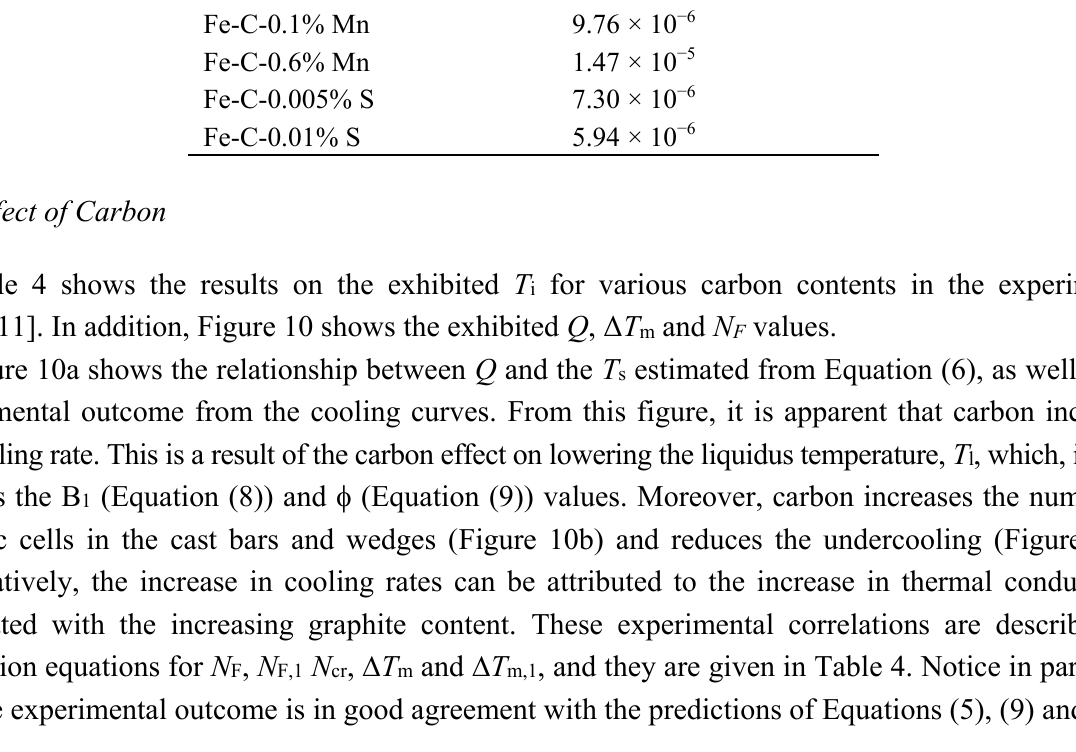
Table 4. Carbon content in cast iron and experimental T i